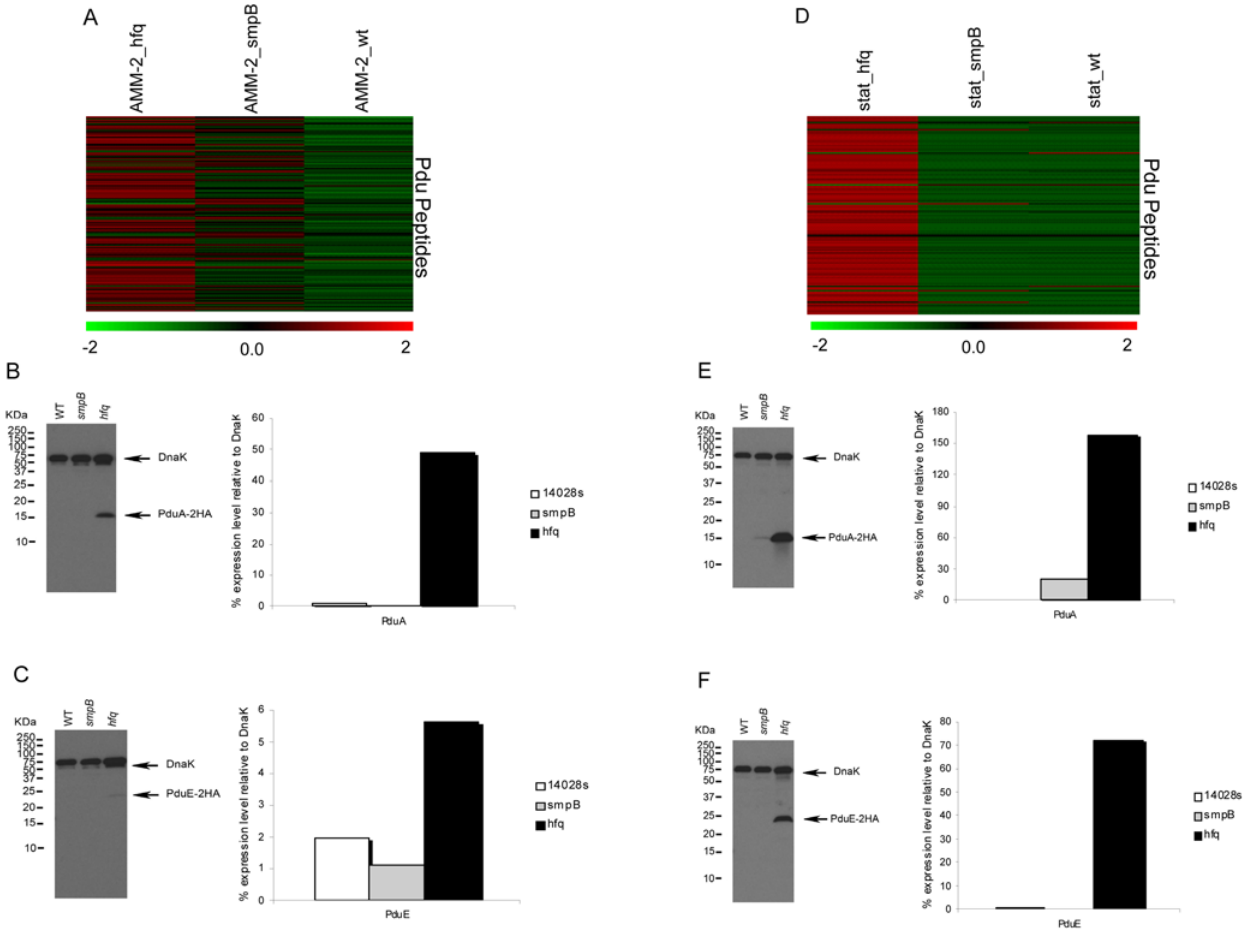
Figure 4. Measurement of protein levels of pdu genes in D smpB and D hfq strains grown under LB Stat and acidic minimal media conditions. Heatmap showing 134 Pdu peptides that represent 11 individual Pdu proteins up-regulated under acidic minimal media (AMM-2) growth condition (Panel A) and 124 Pdu peptides that represent 11 individual Pdu proteins up-regulated under LB Stat growth condition (Panel D) in D hfq and D smpB strains relative to wild-type. Salmonella strains harboring HA-tag at each Pdu gene were grown in acidic minimal media (AMM-2) (Panel B and C) and under LB stat phase (Panel E and F) as described. Same amount of cell lysates was loaded in each lane and probed by Western blot analysis for the Pdu-encoded proteins and a control protein DnaK. The level of Pdu-encoded protein expressed in each strain was normalized to the DnaK level. Intracellular DnaK level in each lane was set to 100%.